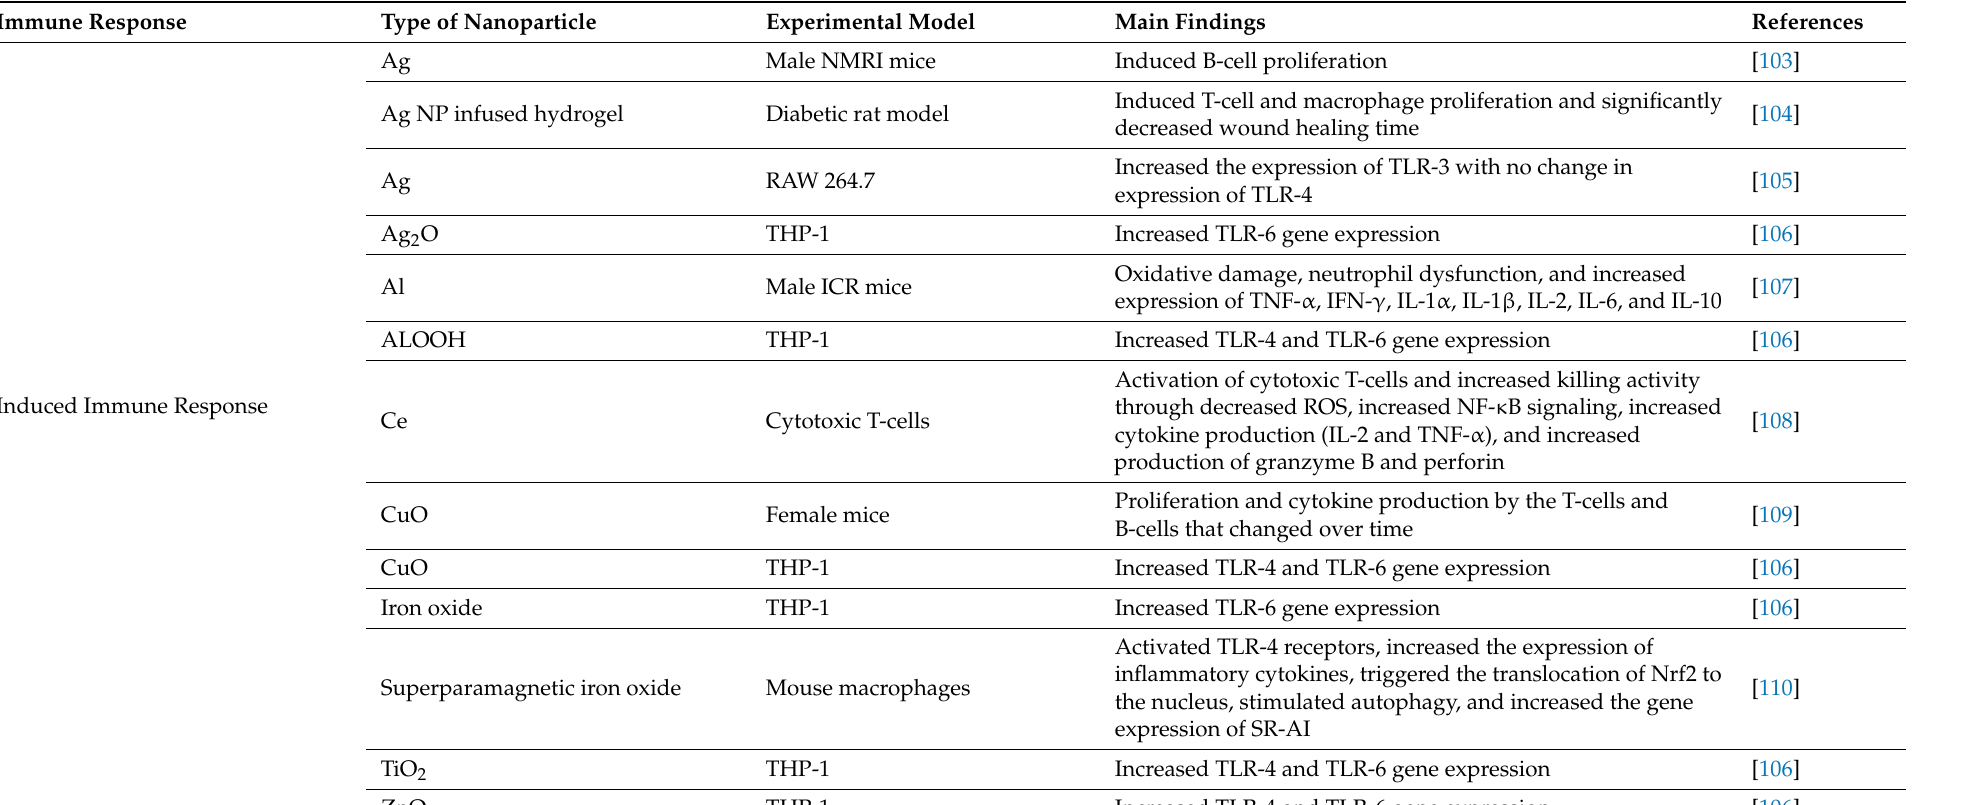
Table 3. Effects of nanoparticles on the immune